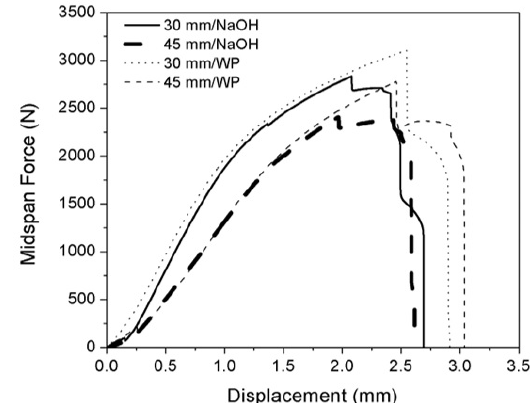
Figure 11. Second-order interaction effect plot for the core shear stress.